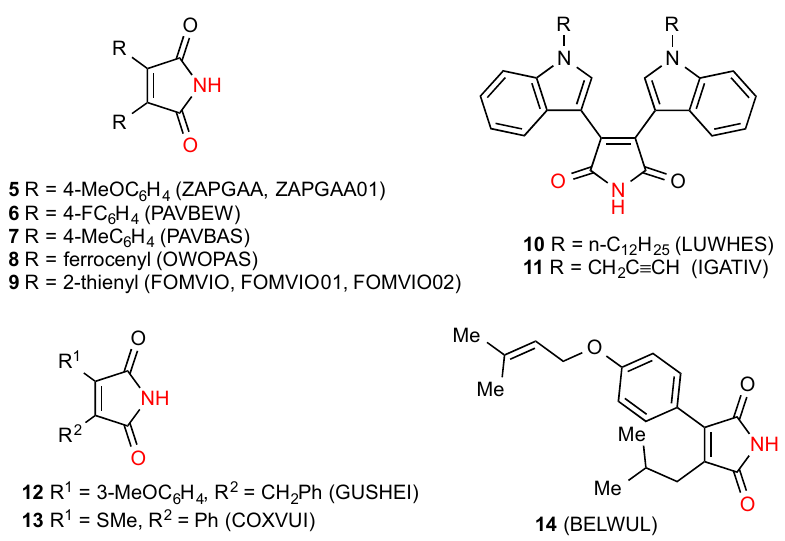
Figure 5. Disubstituted maleimides forming dimers A.